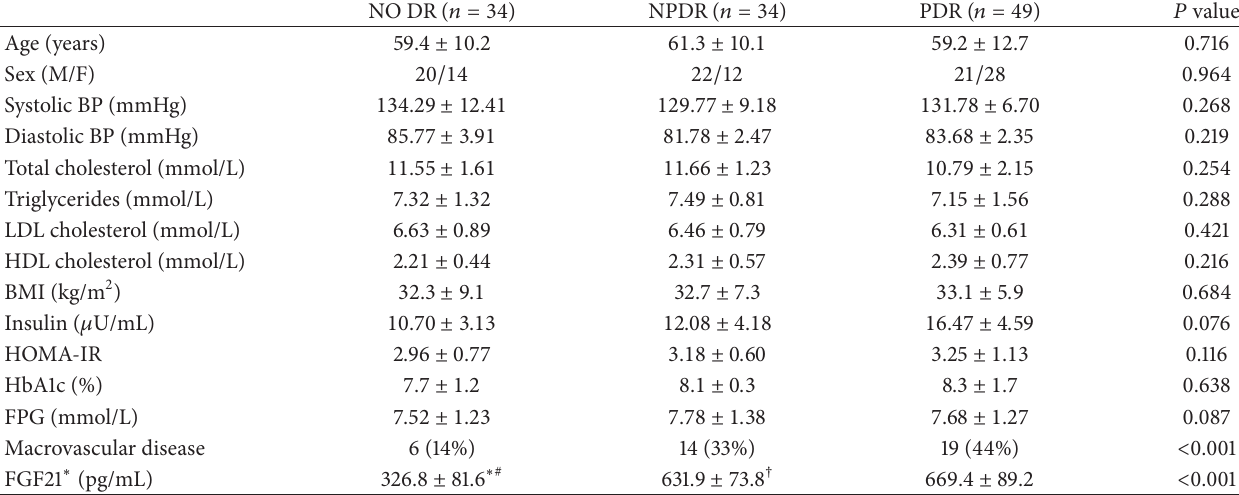
Table 2: Clinical and laboratory features of type 2 diabetic patients with and without retinopathy. Values are means ( ± SD) or number (%).